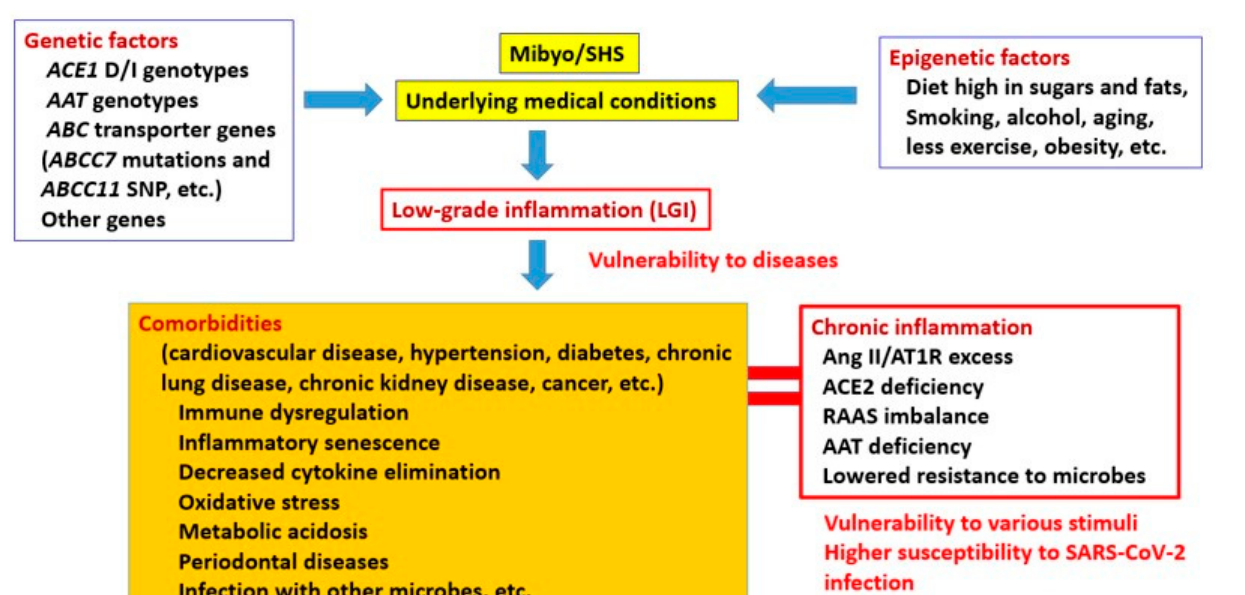
Figure 1. Comorbidities possibly established by interplay among variable genetic and non-genetic factors. Various underlying medical conditions and comorbidities, aging, obesity, and smoking have been reported as risk factors for contracting the new coronavirus infection. Most illnesses are thought to begin with a condition called Mibyo (pre-illness) or Suboptimal Health Status (SHS) [14–16], and as it progresses, some physical conditions occur. Comorbidities seem to be established by a complex intertwining of many genetic and environmental factors. Regarding genetic factors, the relationship between comorbidities and ACE1 genotypes, especially the DD type and AAT deficiency, has been studied extensively (see text). A common feature of patients with underlying medical conditions and comorbidities is mild inflammation (low-grade inflammation, LGI) presenting with dysregulation of the immune system. In the ACE1 DD genotype, renin–angiotensin–aldosterone system (RAAS) activation and oxidative stress, which lead to immune activation, are considered to be important. The effect of individual gene mutations is mild, but these gene mutations might have a great effect when combined with surrounding genes, or variants of completely different genes, and other non-genetic factors, such as lifestyle-related factors (e.g., a diet high in sugars and fats). Comorbidities are thought to make patients vulnerable to a variety of stimuli because of the many intrinsic problems they have [17–20]. Especially in the case of SARS-CoV-2 infection, it may be due to their increased susceptibility to such infection.